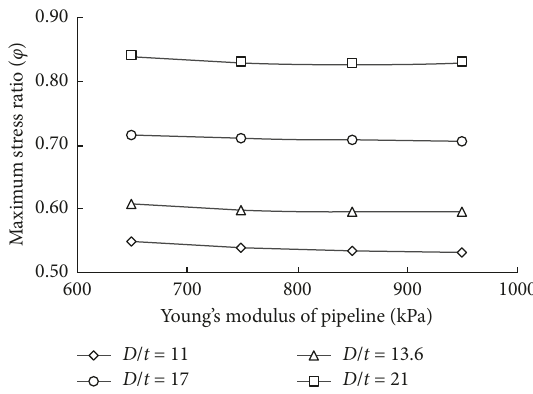
Figure 11: Influence of pipeline Young’s modulus on the maxi- mum stress